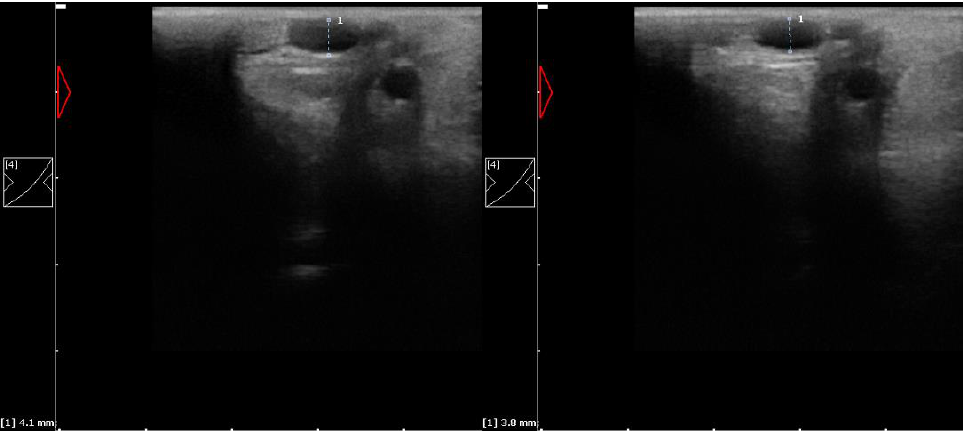
Figure 1. Transverse ultrasound images of the medial palmar vein, with diameter measurement of the right carpal joint taken before ( left ) and just after HILT ( right ).